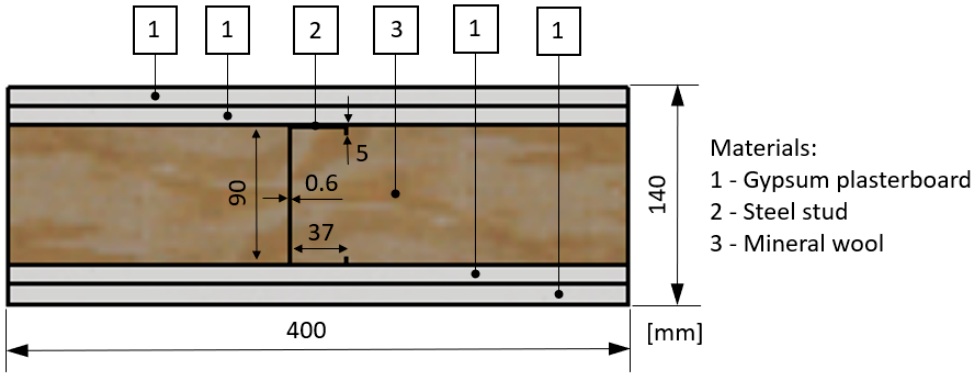
Figure 1. Materials, dimensions, and geometry of the reference LSF partition cross-section. Table 1. Thicknesses ( 𝑑 ) and thermal conductivities ( 𝜆 ) of materials used in the reference LSF parti- tion wall.